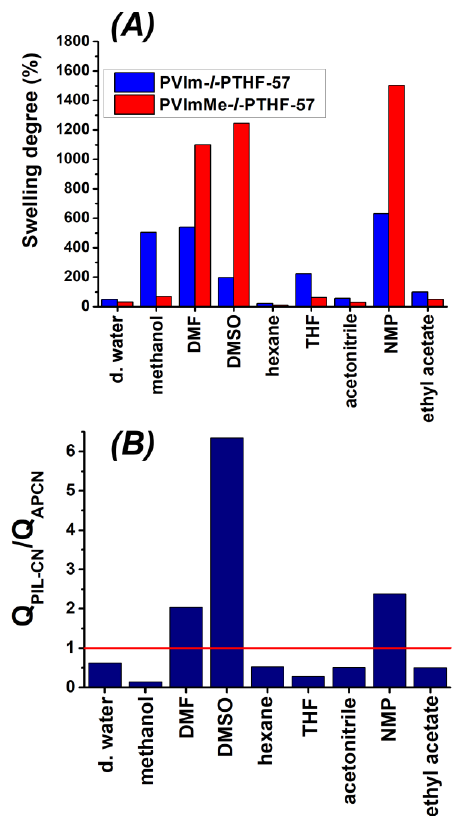
Figure 7. Equilibrium swelling degrees ( A ) and the ratio of the equilibrium swelling degrees ( B ) of PVIm -l- PTHF-57 ( Q APCN ) and PVImMe -l- PTHF-57 poly(ionic liquid) ( Q PIL-CN ) conetworks in different solvents (the red line indicates ratio of one). Table 2. The equilibrium swelling degrees of the PVIm -l- PTHF-57 ( Q APCN ) and PVImMe -l- PTHF-57 ( Q PIL-CN ) conetworks, the ratio of their swelling degrees ( Q PIL-CN / Q APCN ), and the dipole moment, dielectric constant, and polarity index of the investigated solvents.